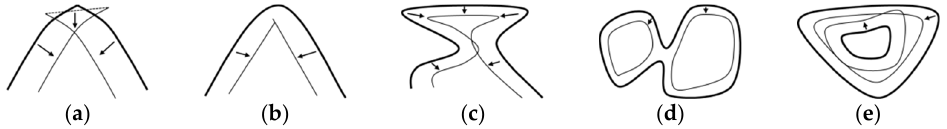
Figure 1. Various problems encountered in contour offsetting [11]: ( a ) Ambiguous normal; ( b ) Singular point; ( c ) Self-intersection; ( d ) Change in topology; ( e ) offset intersection of pocket and island boundary.